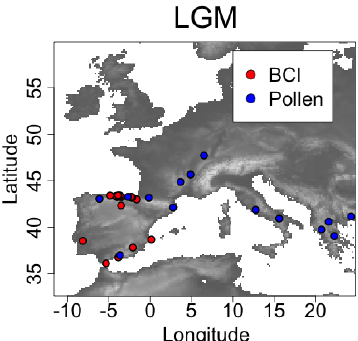
Figure 1. Study area and locations of the sites used for reconstruct- ing local climate variables estimated on the basis of pollen and ver- tebrate fossils, used for the evaluation of the method. The grey scale represents